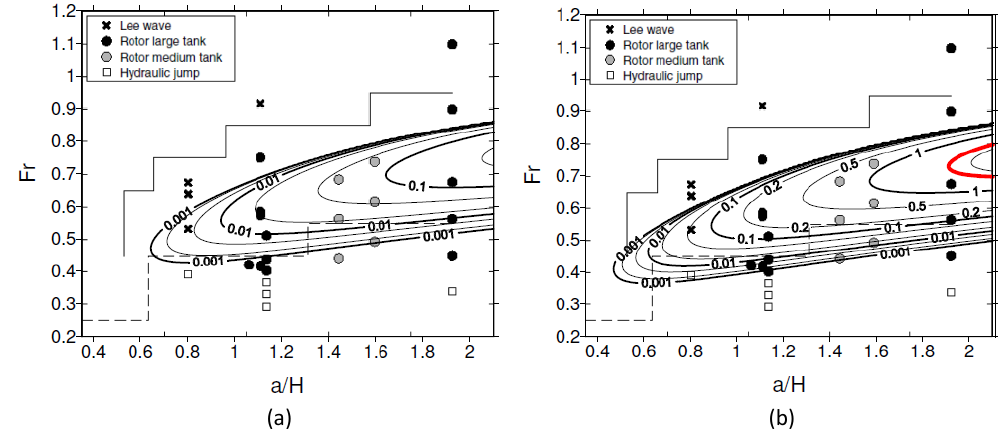
Figure 5. ( a ) and ( b ) should replace Figure 9a,b in